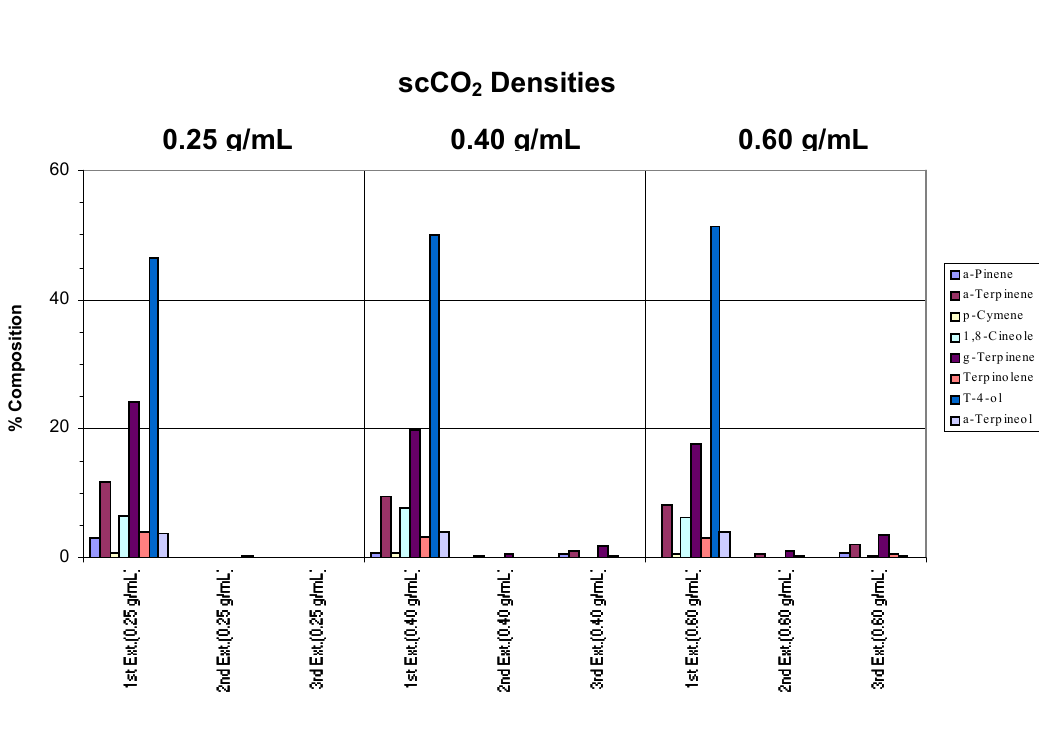
Figure 2b. Recovery of target analytes from whole fresh leaves using a chamber temperature of 80 o